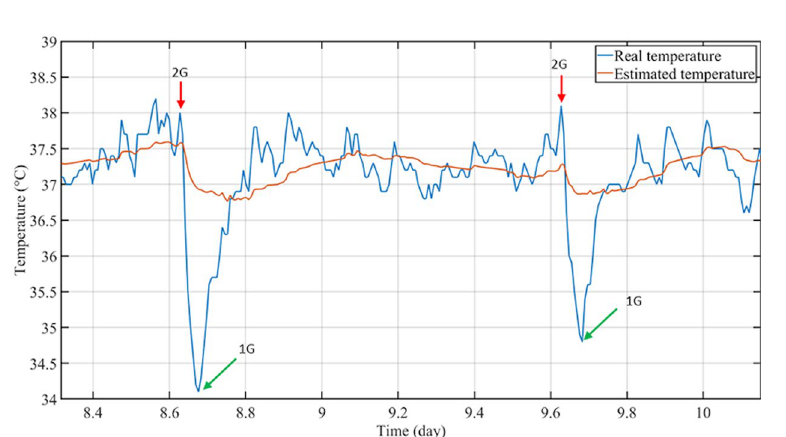
Figure 5. Fall of temperature in sham rats. Descriptive figure of the fall of core temperature (Tc) during the first two 2 G pulses in sham rat 16. Time is represented between the half of day 8 (first pulse) of the experiment and day 10 (0.2 days = 4.8 hours). The blue line represents the raw Tc data recorded by telemetry. The orange line represents the estimated temperature from the extended COSINOR model (see Supplementary Methods). The red arrow indicates the moment where animals were in hypergravity (2 G), and the green arrow indicates the moment where animals went back to 1 G